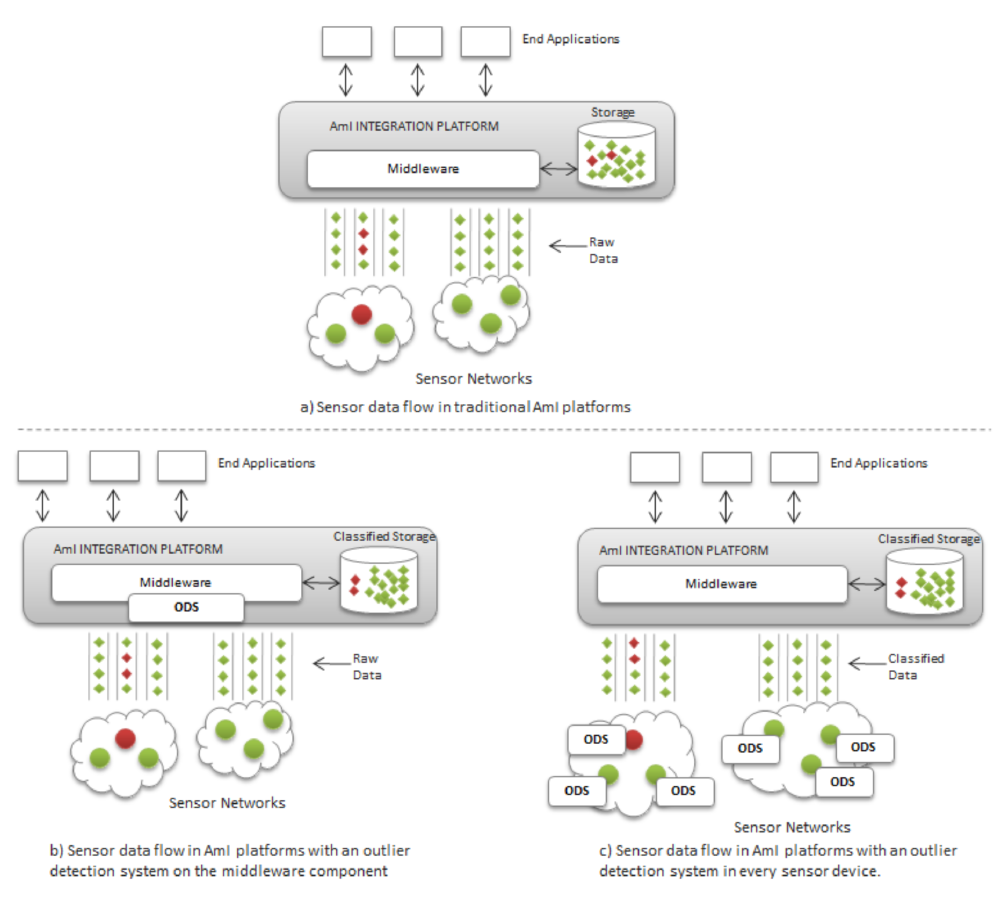
Figure 2. Possible outlier detection systems of erratic sensors in AmI